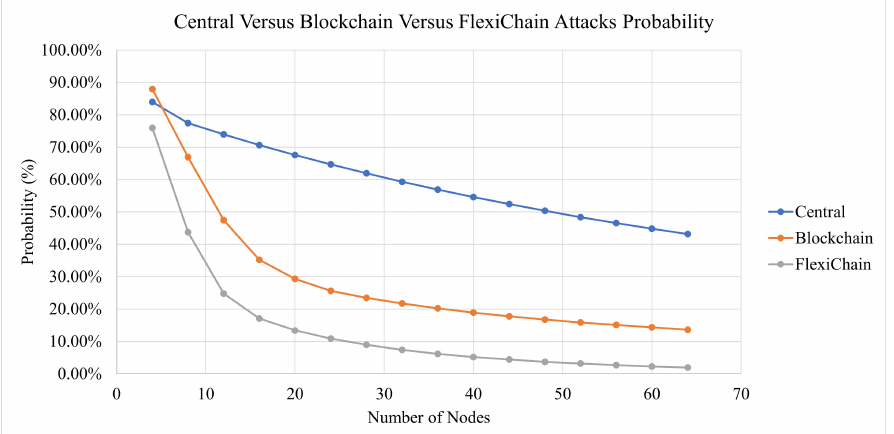
Figure 13. Chart Comparison between Central, Blockchain and